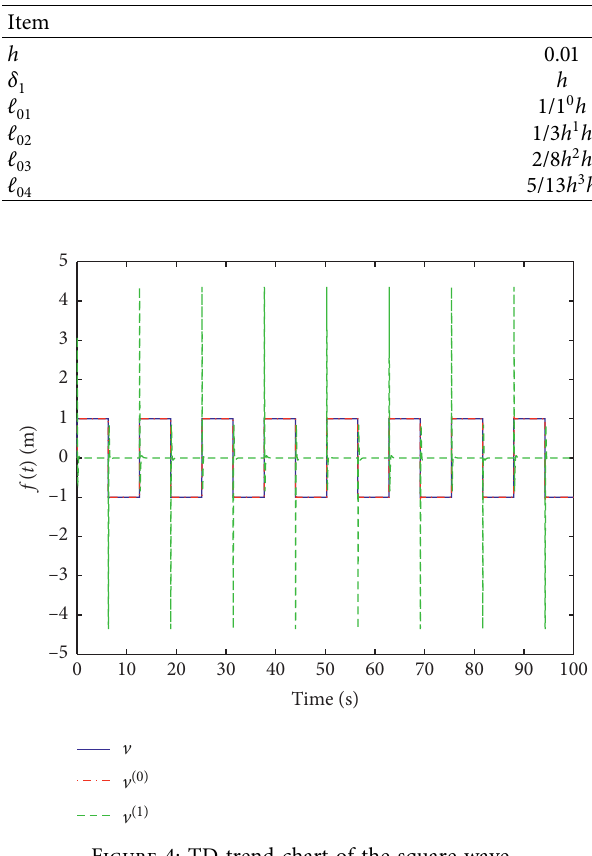
Figure 4: TD trend chart of the square wave.